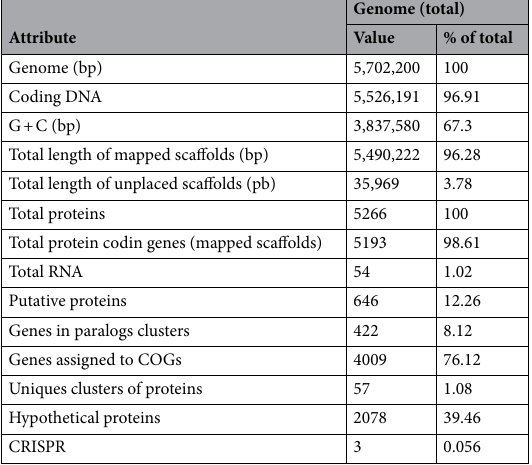
Table 1. General features of TNTM28 genome.